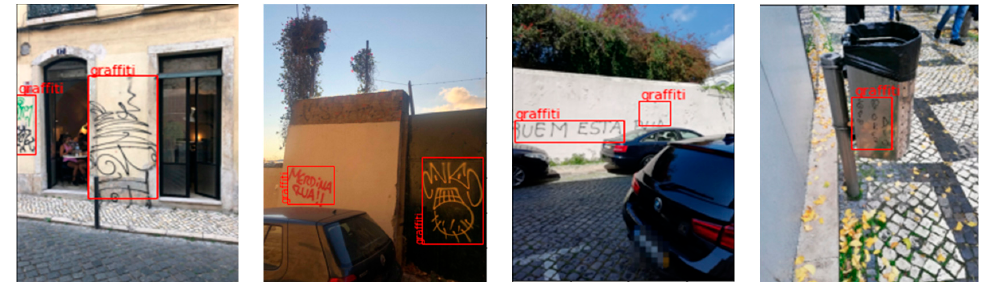
Figure 18. An example of an image where the joining of bounding boxes was necessary.